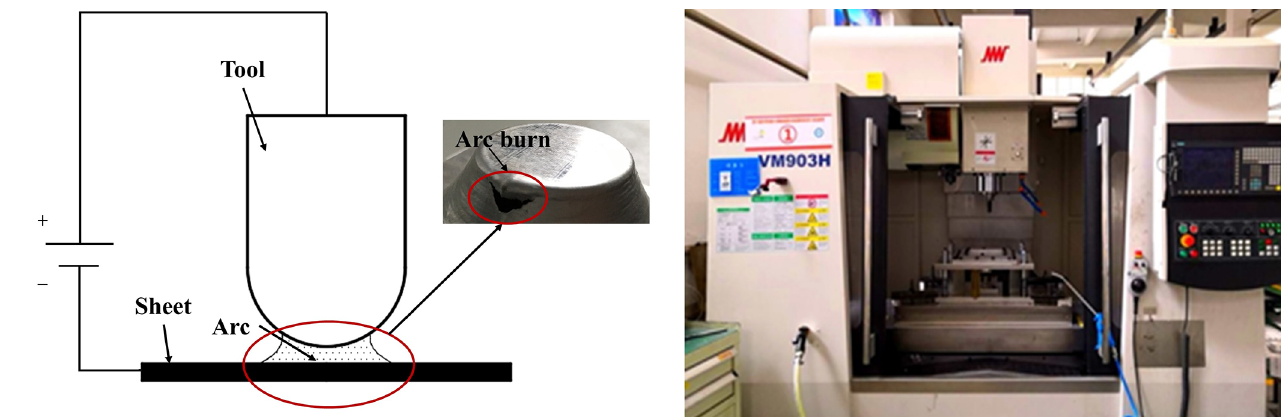
Fig. 1. Sketch of arc burns in EHIF.